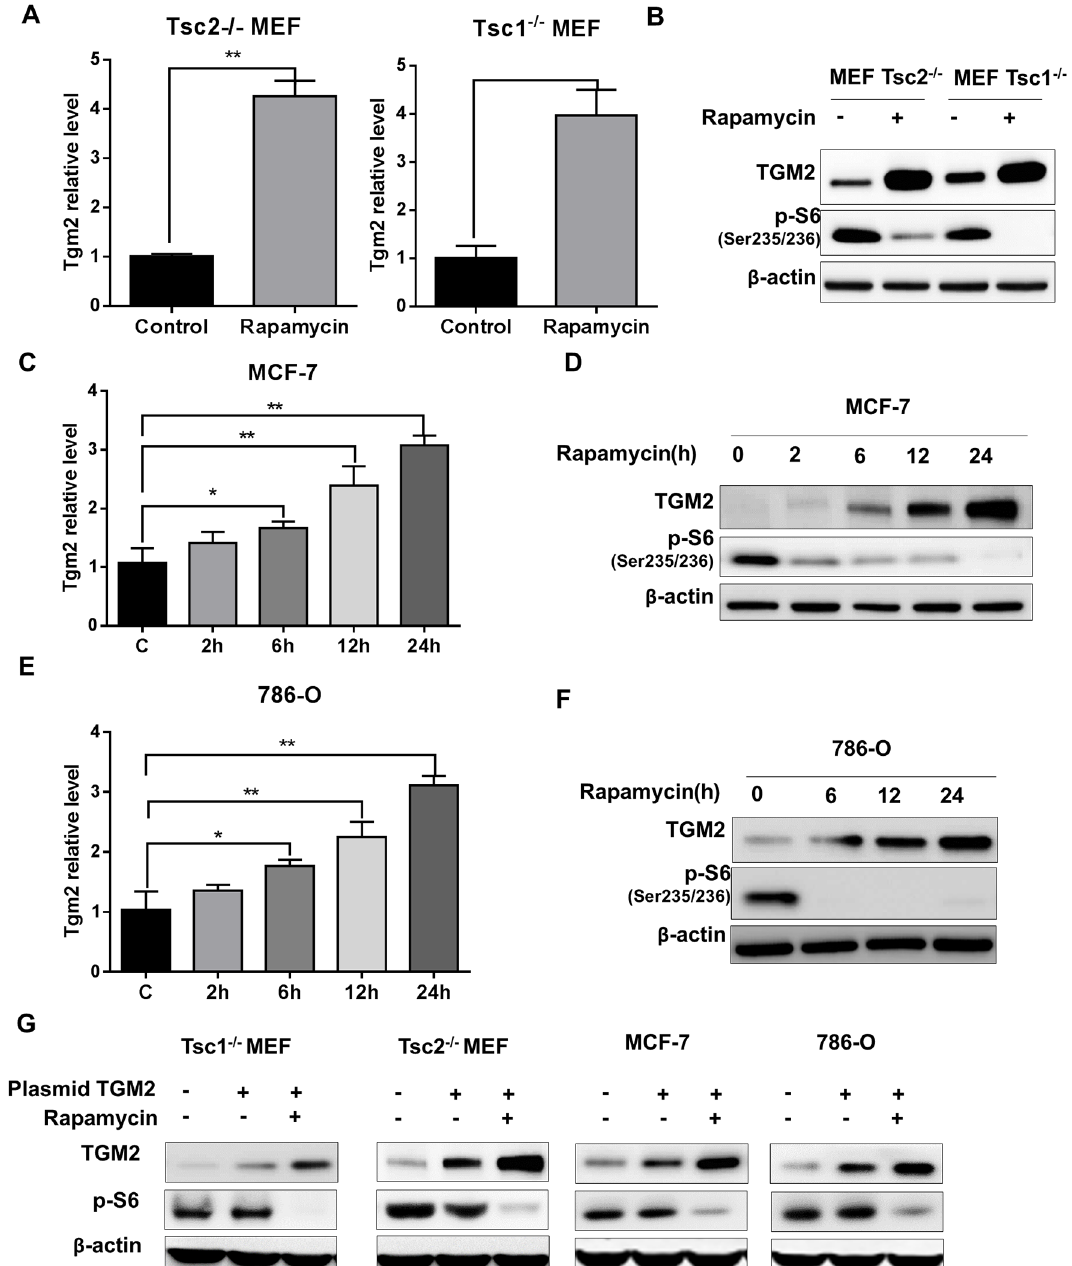
Fig 2. Rapamycin treatment promotes expression of transglutaminase 2. (A) Comparison of Tgm2 transcript levels in Tsc2 -/- and Tsc1 -/- MEF cells treated with either vehicle or rapamycin (n = 3). (B) Immunoblots of TGM2 and phospho-S6 in Tsc2 -/- and Tsc1 -/- MEF cells treated with either vehicle or rapamycin. (C) Tgm2 transcript levels in rapamycin-treated MCF-7 cells at various time points (n = 3). (D) Immunoblots of TGM2 and phospho-S6 in vehicle- and rapamycin-treated MCF-7 cells at various time points. (E) Tgm2 transcript levels in rapamycin-treated 786-O cells at various time points (n = 3). (F) Immunoblots of TGM2 and phospho-S6 in vehicle- and rapamycin-treated 786-O cells at various points. (G) Immunoblots of TGM2 and phosphor-S6 in in vehicle- and rapamycin-treated Tsc1 -/- and Tsc2 -/- MEFs, MCF-7 and 786-O cells transfected with vehicle or TGM2 plasmids. All data are shown as means ± S.D. ** P < 0.01, * P < 0.05, Student ’ s t-test.